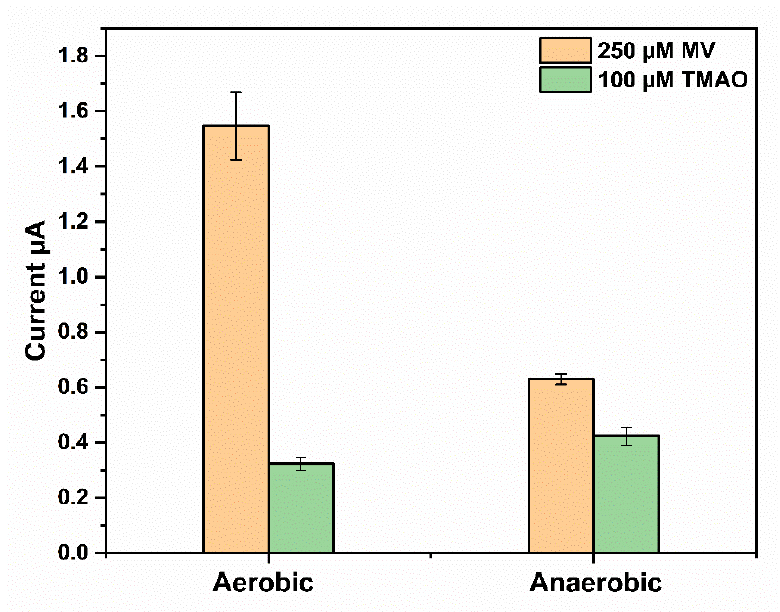
Figure 3. Effect of O 2 on the response of the TMAO sensor. Measurements were performed in Sörensen buffer 67 mM pH 7; 250 µM MV and 100 µM TMAO were used in each experiment; TorA (5.9 nmol/cm 2 ); GOD 10 U, Cat 1000 U, polyvinyl alcohol (PVA) 3% and without (left) and with (right) 3 mM glucose for the anaerobic conditions. (n = 3 electrodes, each 3 measurement) .